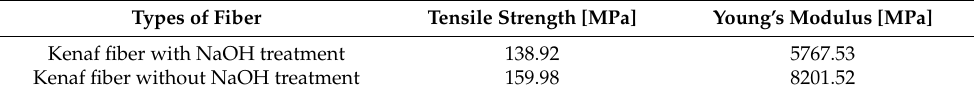
Table 4. Tensile strength comparison between untreated and treated kenaf fiber.